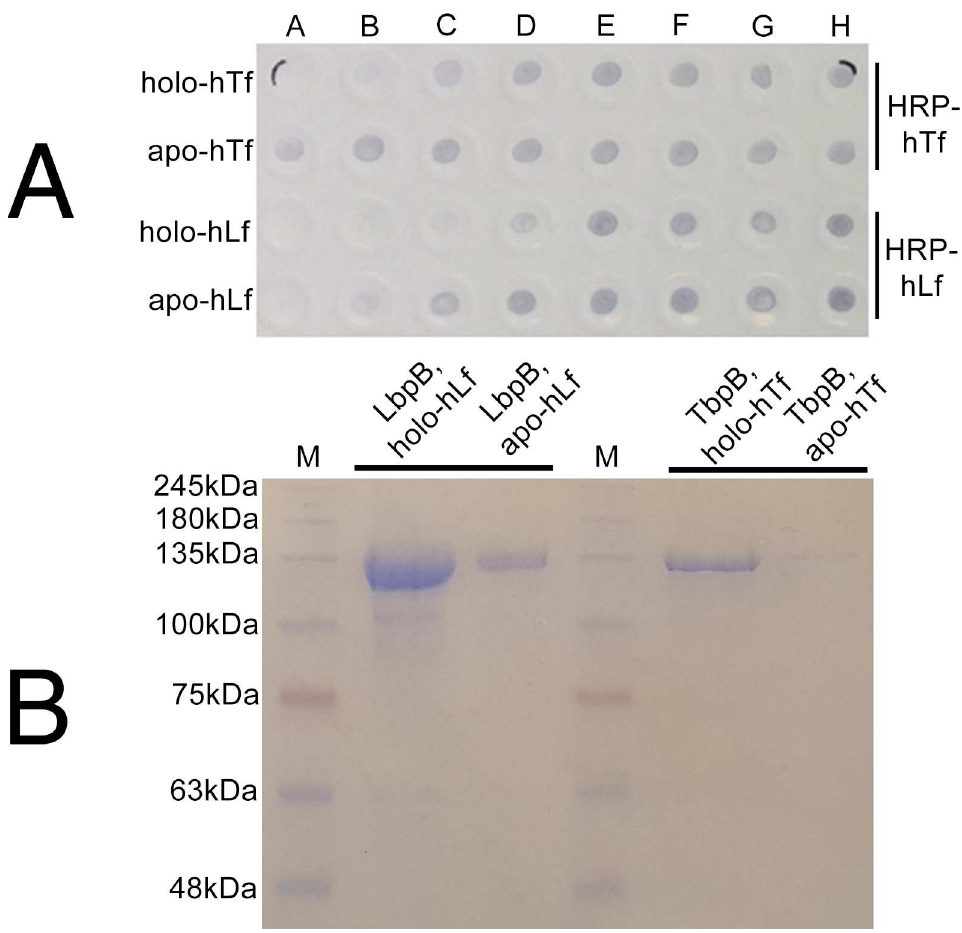
Fig 2. Specificity of LbpB and TbpB for iron-loaded glycoprotein. (A) Competitive solid-phasebinding assay of TbpB with apo/holohTf and LbpB with apo/holohLf. RecombinantMBP-TbpB (top two rows) and MBP-LbpB (bottom two rows) were appliedto nitrocellulose paper, the paper blockedand then incubatedwith apo- or holo- glycoprotein overnightin a ¼ serially diluted fashion(A, 20nM; B, 5nM; C, 1.25nM; D, 0.31nM; E, 0.07nM; F, 0.01nM; G, 4.88 × 10 -3 nM; H, 0nM). Iron-loaded HRP-conjugated glycoprotein(HRP-hTf or HRP- hLf) was then introducedinto the bindingmixture. Presence of a dot represents the displacement of any protein bound to TbpB or LbpB by the HRP-conjugateat the given concentration. (B) SDS-PAGE/affinity capture representing receptor protein (MBP-TbpB, 122kDa;or MBP-LbpB, 122kDa)captured by Sepharoseresins conjugated to their cognateapo- or holo-glycoprotein (hTf-r,